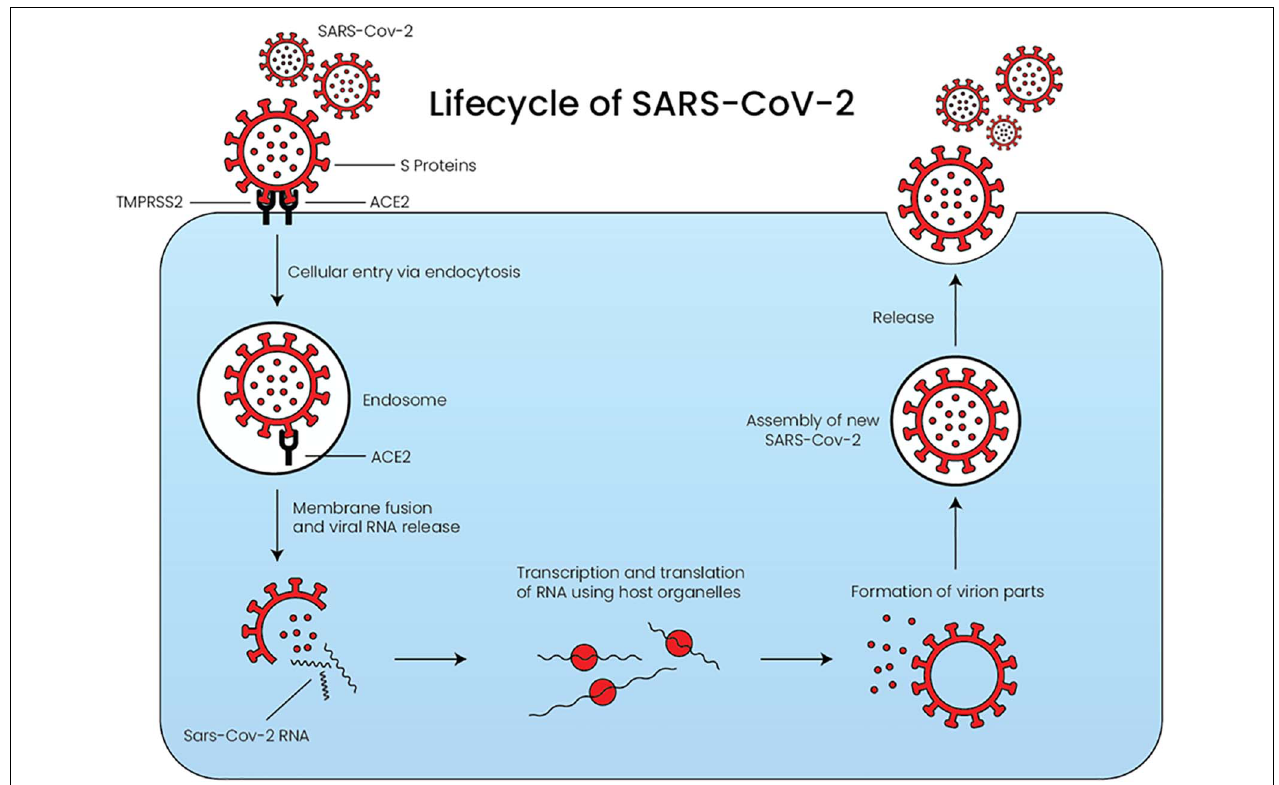
FIGURE 2 | The lifecycle of SARS-CoV-2 starting from the penetration of the virus into the cell until its release. The virus requires both ACE2 and TMPRSS2 to facilitate its entry. ACE: angiotensin converting enzyme, TMPRSS2: transmembrane protease serine